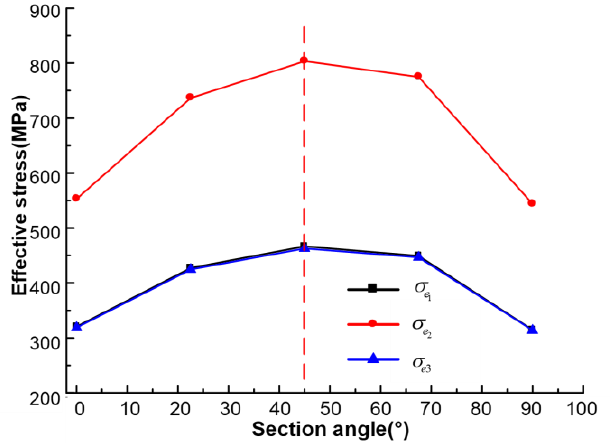
Figure 8. Effective stress of different weld section angles in the longitudinal fillet weld.